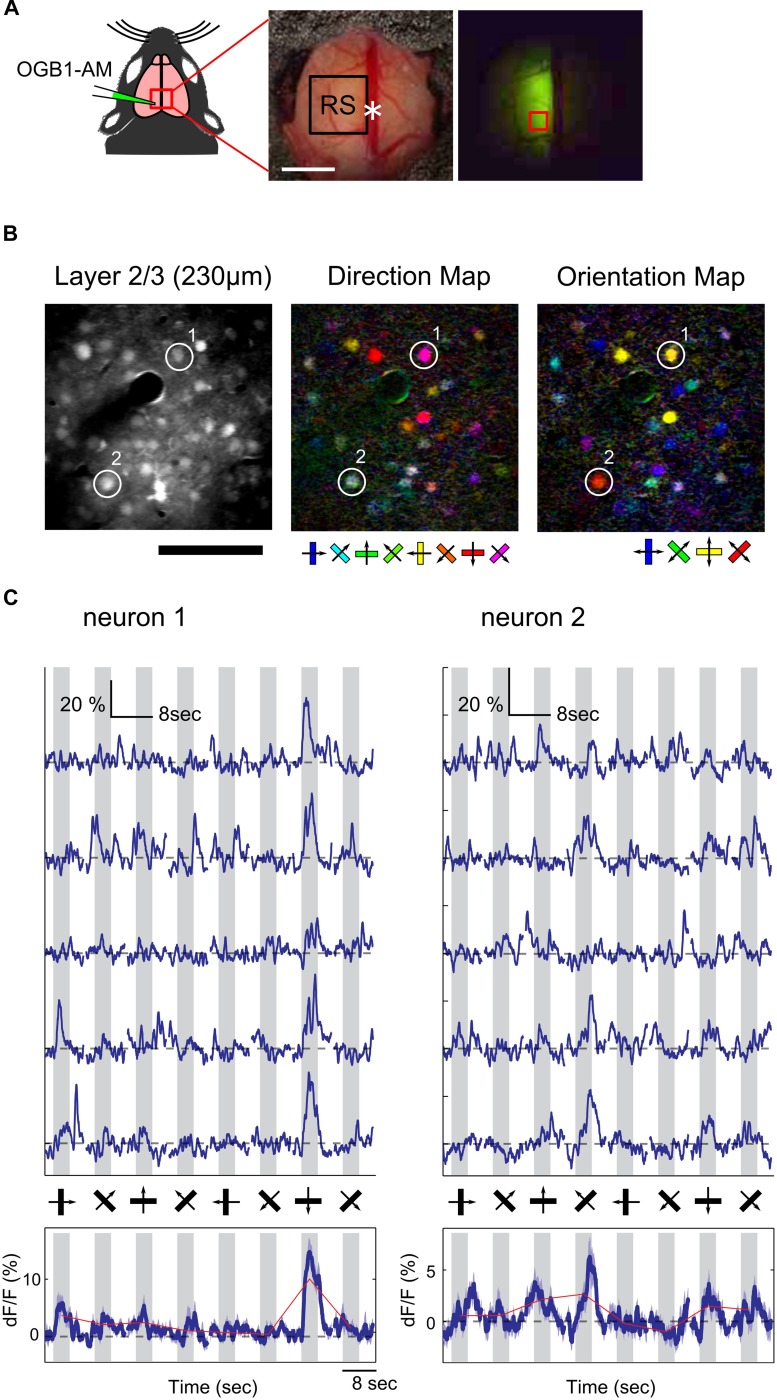
Two-photon Ca2+ imaging in the RS. (A) Schematic of OGB1-AM injection in the RS. White asterisk: landmark position of the RS (2.5 mm anterior from lambda). Scale bar, 1 mm. (Right) An example of an OGB1-AM injected region. Red square: imaging FOV shown in (B). (B) Representative FOV (left) and color-coded maps of preferred direction (center) and orientation (right) of neurons in the RS. Scale bar: 100 μm. (C) Representative time courses of two neurons shown in (B). (Upper) Examples of five trials. (Bottom) Averaged time courses from 15 trials. Dashed line: baseline of Ca2+ signal. Gray shade: stimulus period.